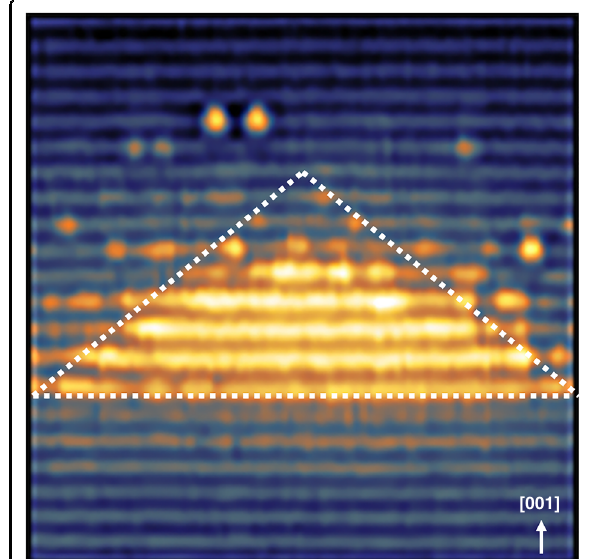
biggest QD taken at V b = − 3.3 V and I t = 50 pA with white dotted lines showing a cut through the pyramid. The diagonal base length of the QD is 11 ± 0.2 nm with a height of 5 BLs and the arrow indicates the growth direction